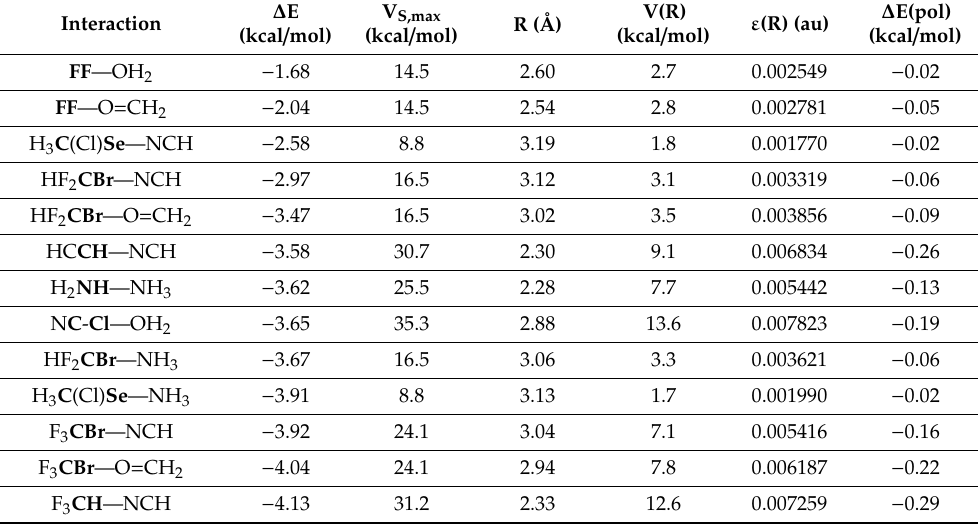
Table 1. Computed data for σ -hole interactions. The σ -hole is on the extension of the bond between atoms, and it is indicated in bold . Dashed lines show interactions. ∆ E is interaction energy, as shown in Equation (2). V S,max is the most positive electrostatic potential of the σ -hole on the 0.001 au molecular surface before interaction. R is equilibrium interaction separation. V(R) and ε (R) are the electrostatic potential and electric field of the σ -hole molecule at the approximate position of the negative site. ∆ E(pol) is the energy of polarization of the negative site, as shown in Equation (6).